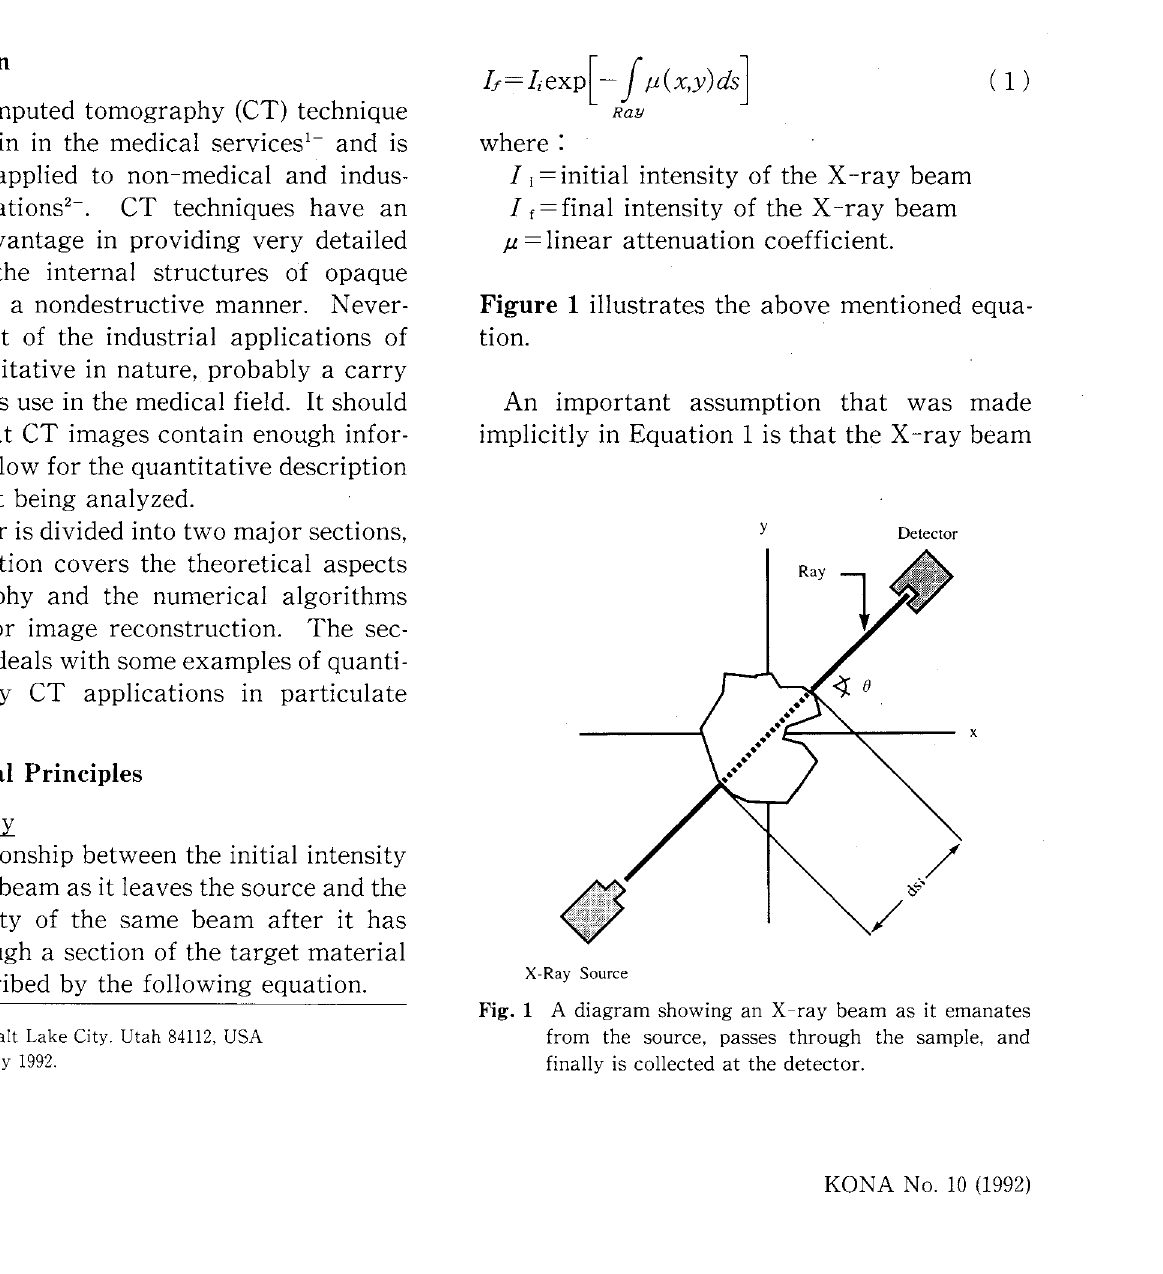
Fig. 1 A diagram showing an X -ray beam as it emanates from the source, passes through the sample, and finally is collected at the